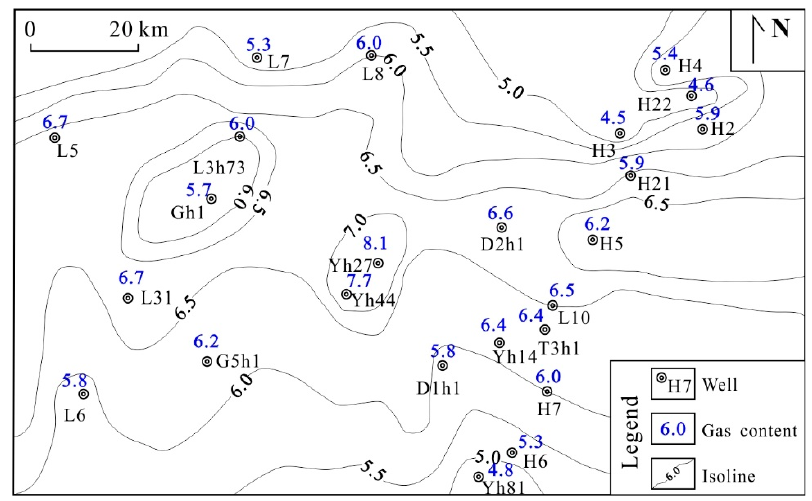
Figure 4. Contour map of shale gas content in the Longmaxi Formation in the study area. Table 6. Water saturation of the Longmaxi Formation shale of different drilling wells in the study area. Water Saturation Well